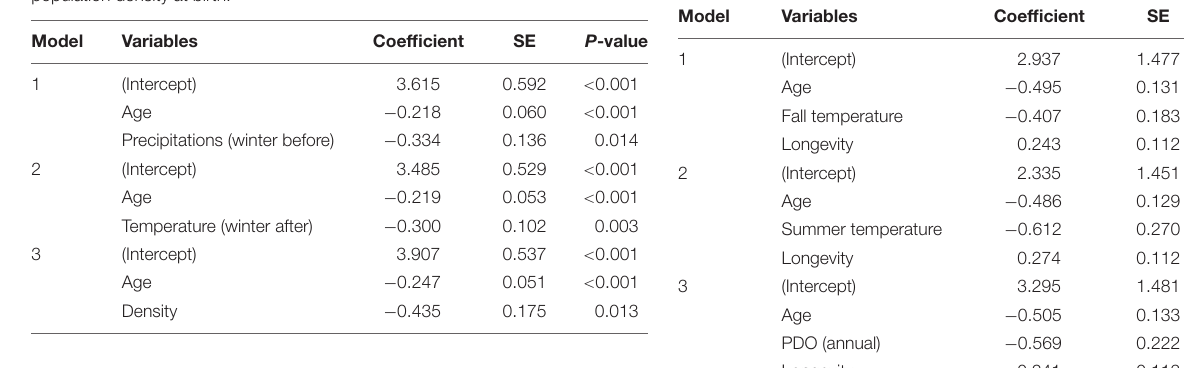
TABLE 2 | Estimated coefficients, standard errors (SE) and corresponding P -values of the three generalized linear mixed-effects models showing how survival at old ages is affected by age, precipitations during the winter before preceding birth and temperature during the winter following birth for bighorn sheep females born at Ram Mountain, Canada, from 1973 to 2004, and by population density at birth.